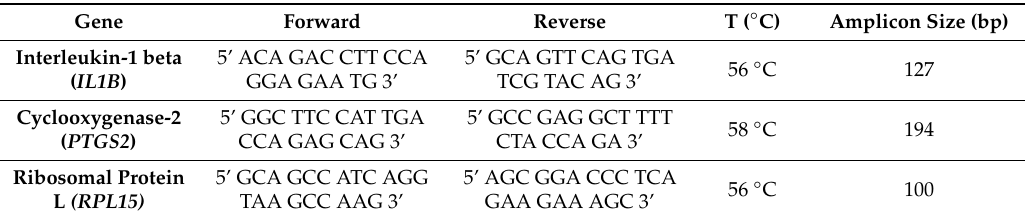
Table 2. Primers used for the real-time